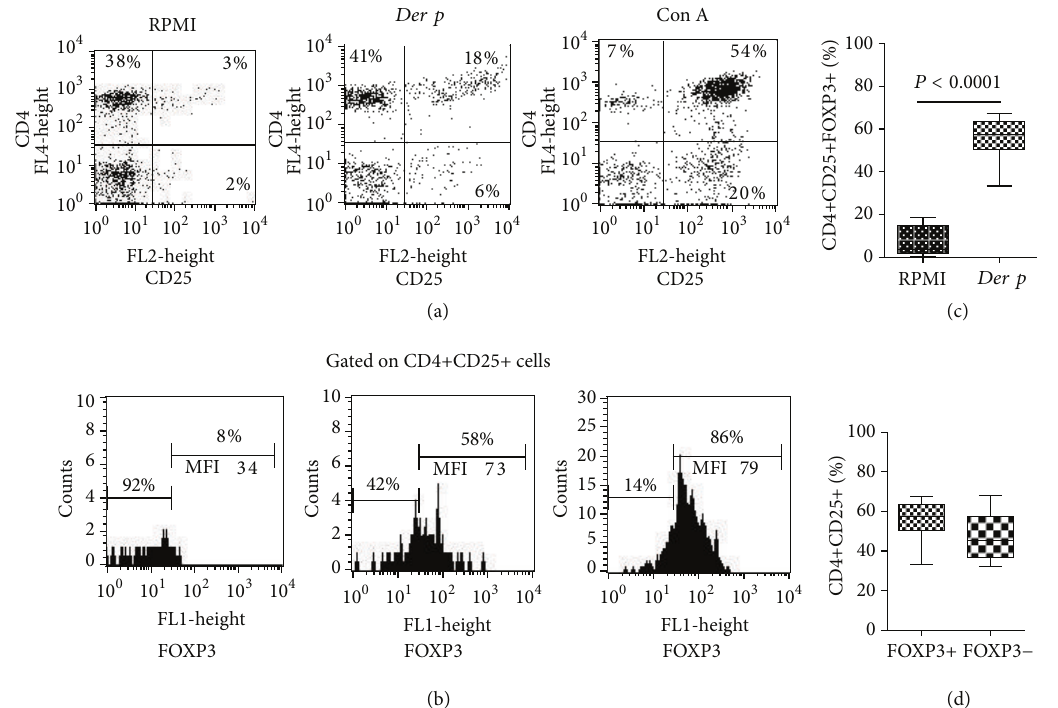
Figure 3: Frequency of CD25+ cells and CD4+CD25+FOXP3+ regulatory T cells after stimulation. (a) Representative dot plots of PBMC stimulated with Der p or Con A in patients with PAC. (b) Comparative histograms of FOXP3+ frequency on CD4+CD25+ gated cells. The 𝑥 -axis denotes the mean fluorescence intensity (MFI) of FOXP3. (c) Significant differences were observed in the frequency of Tregs upon Der p -stimulation. (d) Distribution of FOXP3+ and FOXP3 − cell subsets on CD4+CD25+ gated cells after allergen-stimulation.